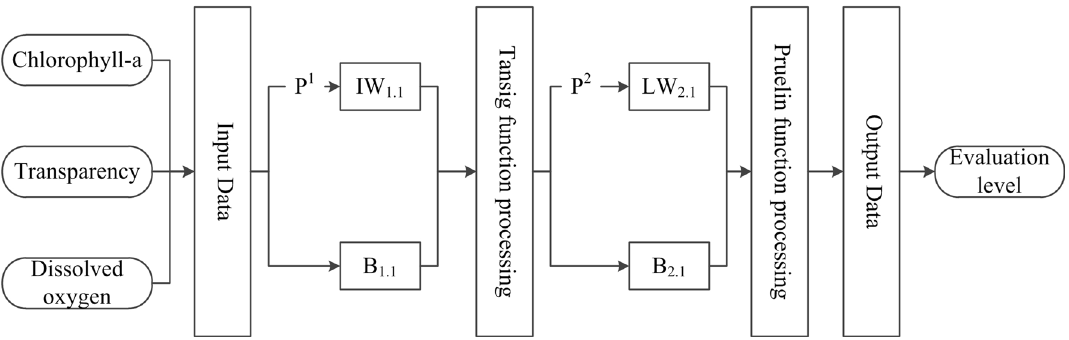
Fig. 2 Structure of BP neural network (P is the source data; IW is the weight from input layer to hidden layer; LW is the weight from hidden layer to output layer; B is the threshold from input layer to hidden layer; B 2.1 is the threshold from hidden layer to output